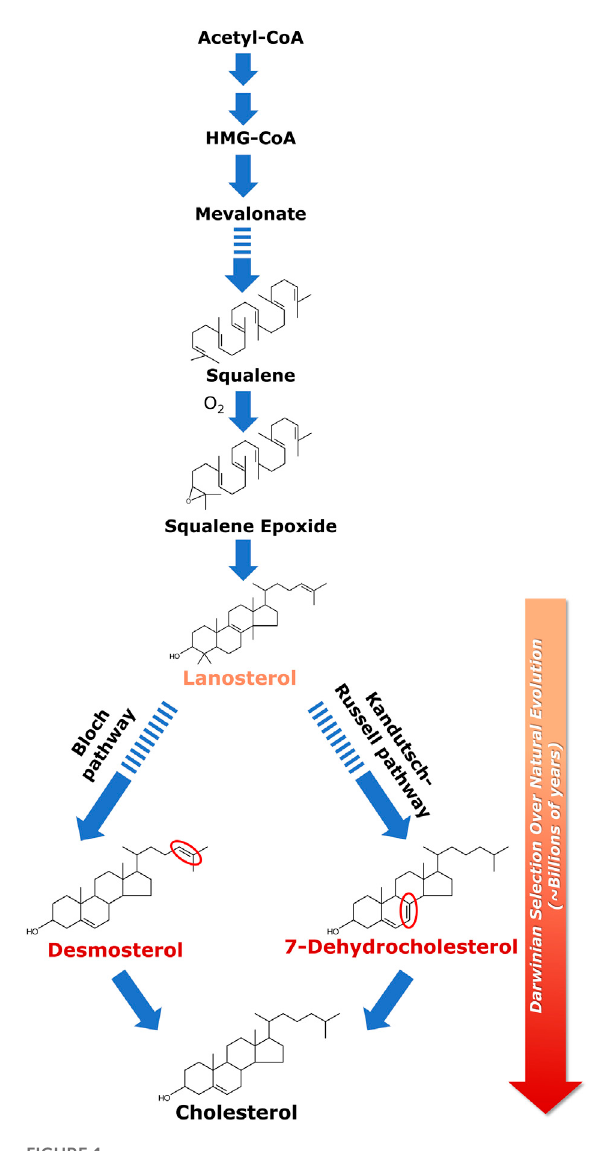
FIGURE 1 Biosynthesis of cholesterol and its evolutionary relevance.